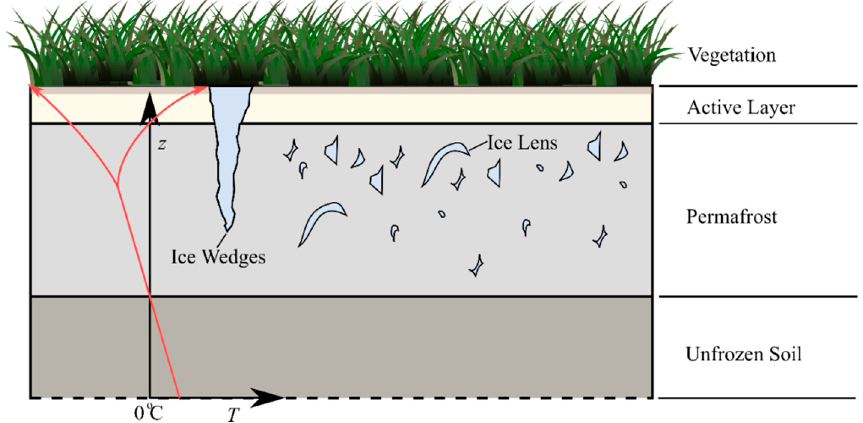
Figure 1. Vertical structure of permafrost soils. The red line shows a conceptual temperature profile through the soil.